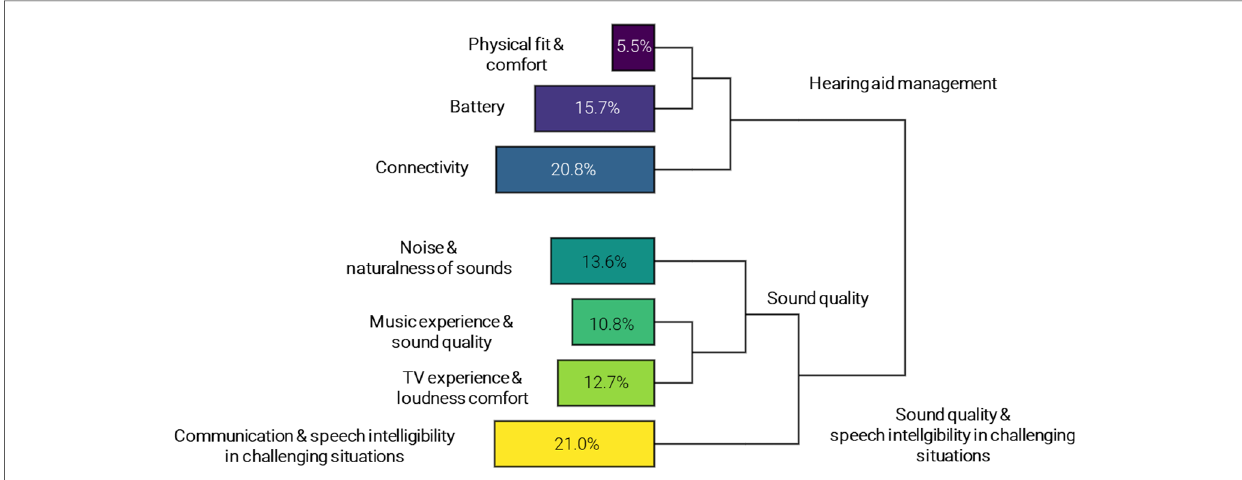
FIGURE 3 Graphical overview of the outcomes of the cluster analysis. The lines visualize the structure of the clustering, i.e., the two main branches on the right ( “ hearing aid management ” and “ sound quality & speech intelligibility in challenging situations ” ) and subsequent bipartitions, resulting in seven clusters. The percentages in the bars represent the size of each cluster. The clusters were named by the researchers based on characteristic words and text